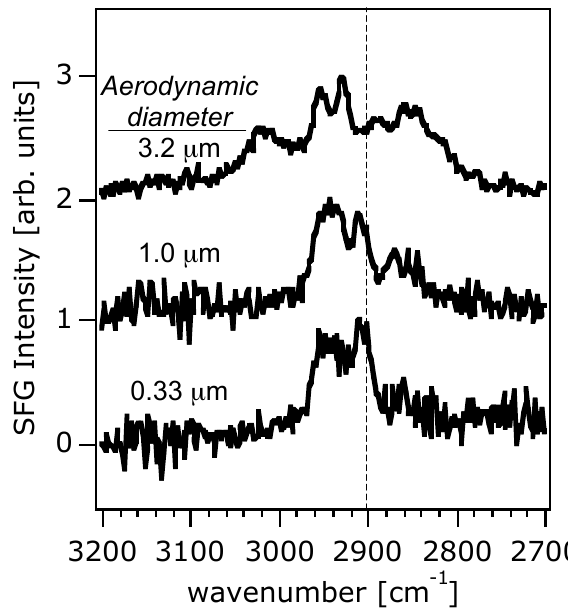
Fig. 5. SSP-Polarized vibrational SFG spectra of an optical window in contact with impactor substrates containing aerosol particles hav- ing (top to bottom) aerodynamic diameters of 3.2, 1.0, and 0.33µm that were collected in the central Amazon basin during the 2008 wet season. All spectra normalized to the highest peak intensity, and offset for clarity. The vertical dashed line at 2900cm − 1 dissects the frequency location of asymmetric and symmetric CH stretching modes of aliphatic hydrocarbon species to the left and right of it, respectively.